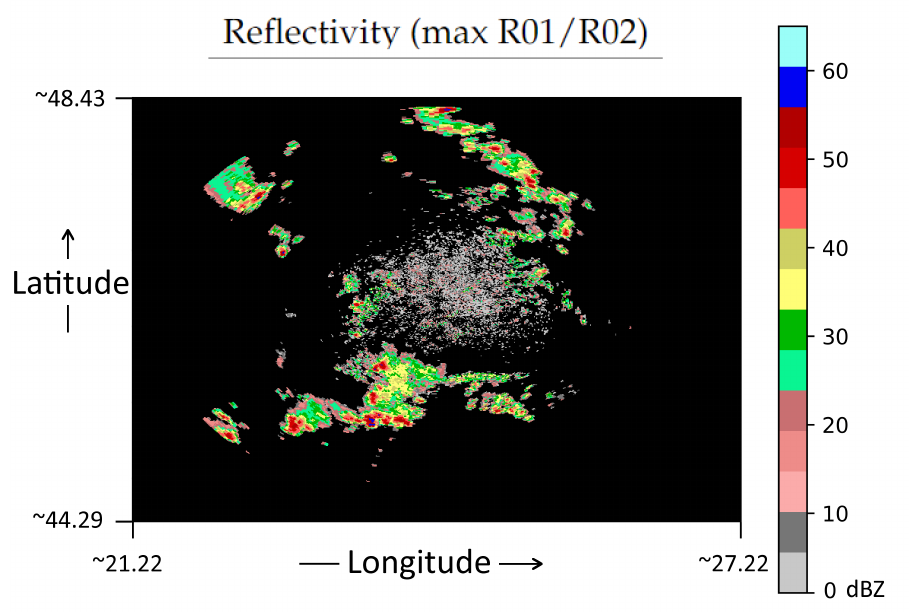
Figure 10. Max R01 or R02 values,in dBZ, in 27 June 2016 between 18:03 and